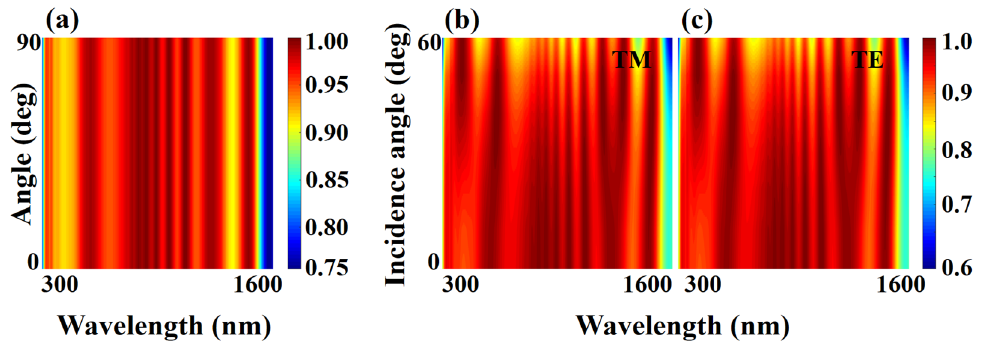
Figure 6. ( a ) The effect of different polarized light on the optical absorption of the device. ( b ) The effect of different incident angles on the optical absorption of the device in TM mode. ( c ) The effect of different incident angles on the optical absorption of the device in TE mode.